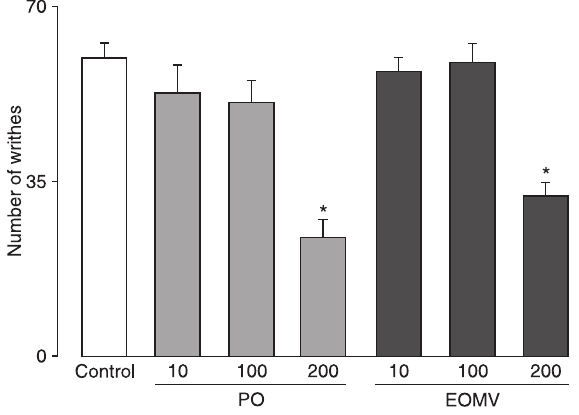
Figure 1. Inhibitory effect of the essential oil of Mentha x villosa (EOMV) and piperitenone oxide (PO) on the nociceptive reaction to intraperitoneal acetic acid injection in mice. Data are reported as the mean number of writhings (± SEM) after oral administra- tion of PO and EOMV in 10 animals per group. *P ≤ 0.05 com- pared to the control (ANOVA and Dunn